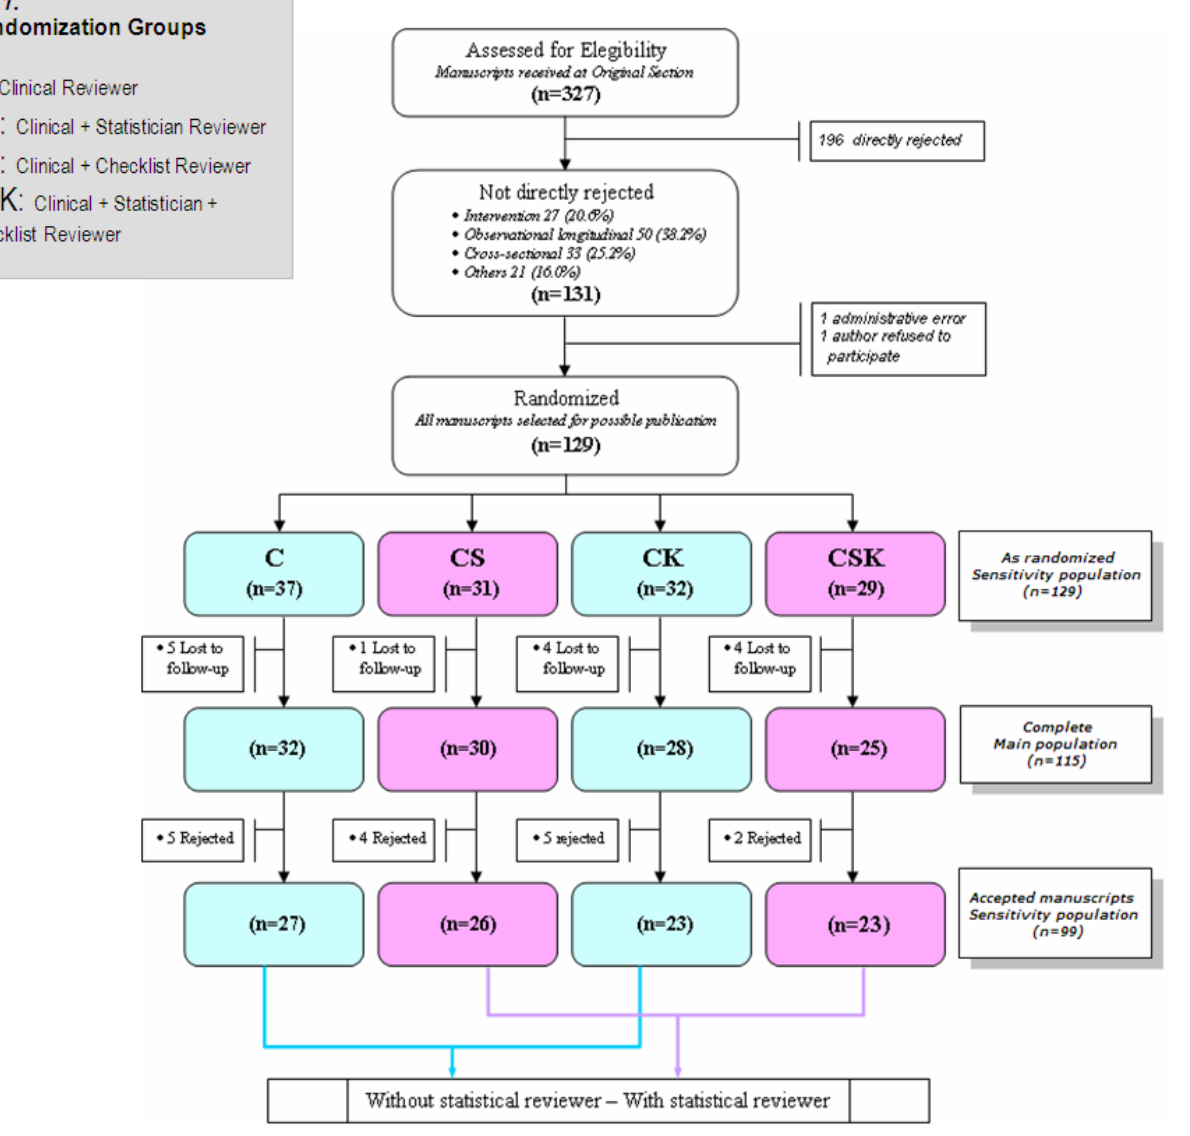
Figure 1. Flow chart of the review process among the four randomization groups. From 131 selected papers for possible publication, 129 were randomized and allocated into four comparison groups in a 2 6 2 factorial design to evaluate the effects of adding a statistical expert as a reviewer and of suggesting the use of checklists. Main analyses are based on the 115 papers which completed the review process.